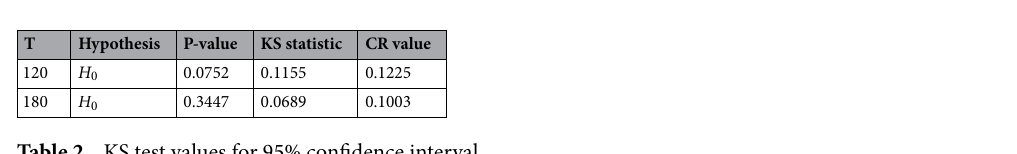
Table 2. KS test values for 95% confidence